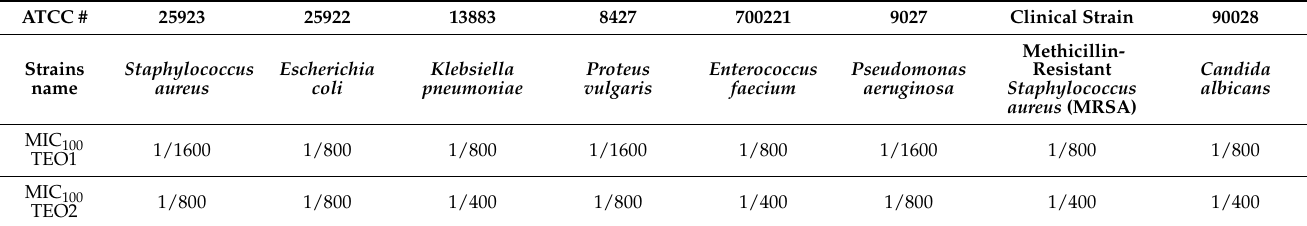
Table 2. MIC 100 values were determined for Thymbra essential oils against different